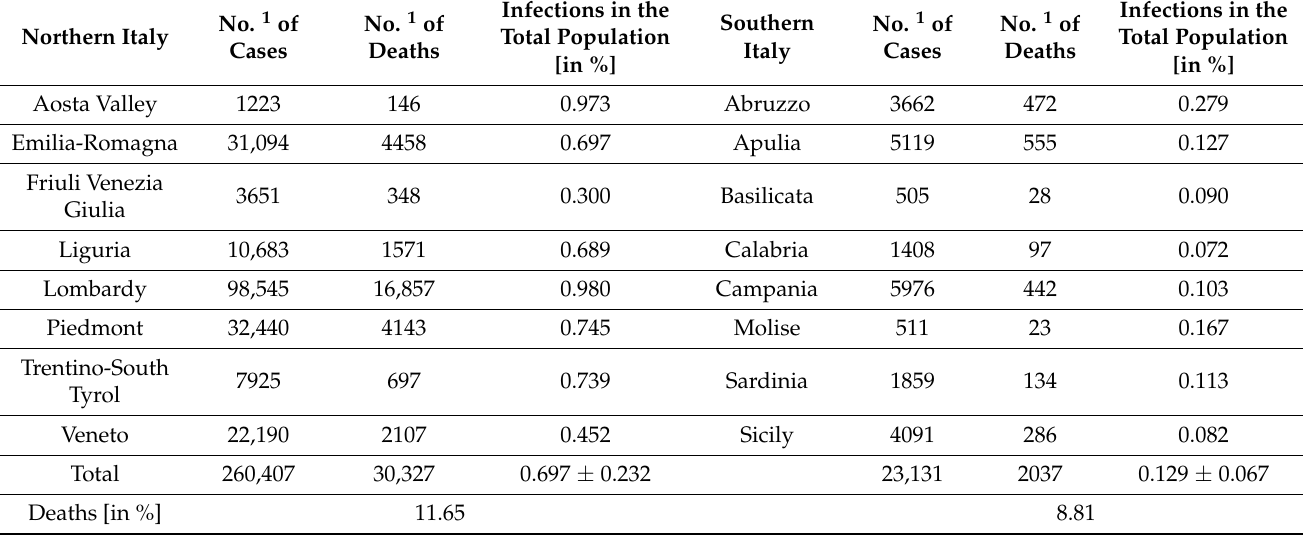
Table 1. Epidemiological data in northern and southern